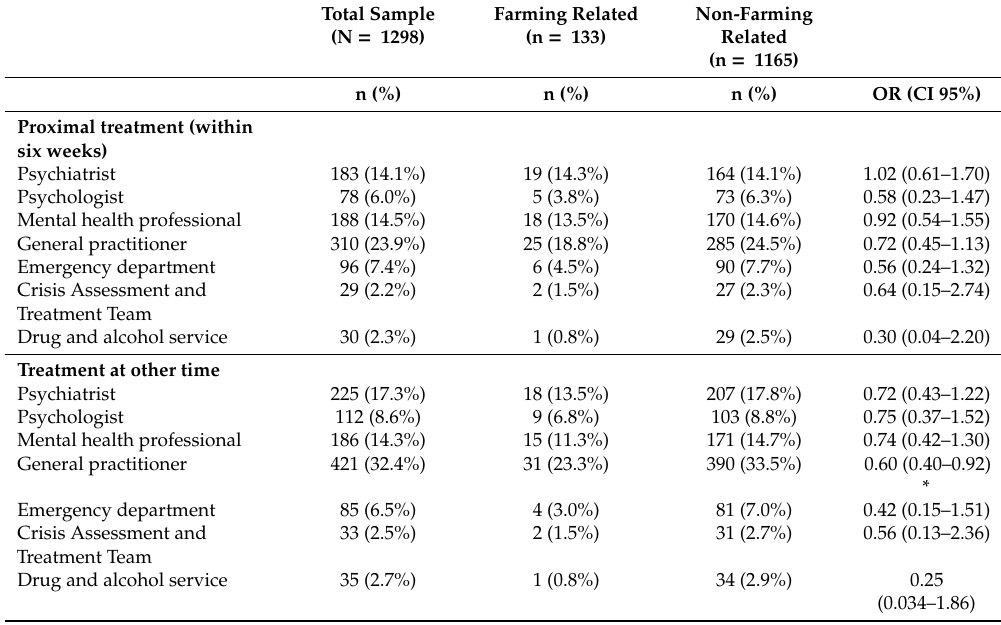
Table 4. Mental Health Treatment Services Accessed Prior to